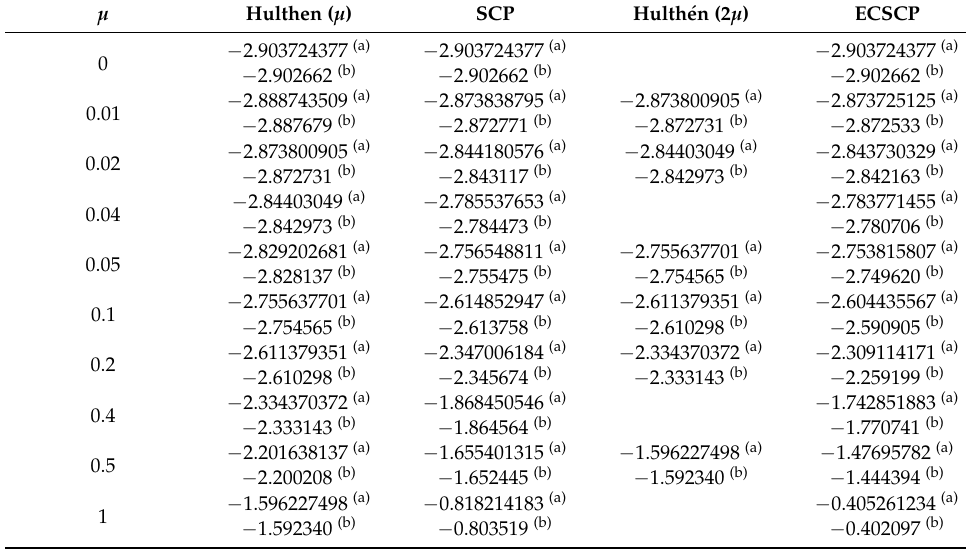
Table 4. Comparison between (a) LMM and (b) VMC for the ground state energies of the helium